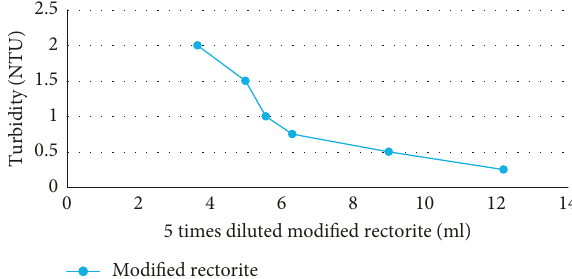
Figure 4: Turbidity of raw water of tap water treated with modified